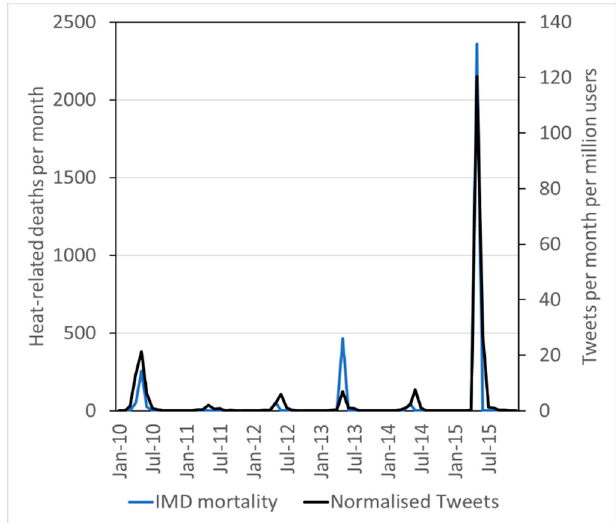
Figure 6. Number of tweets about heat waves in India per million users per month and number of heat-related deaths per month.